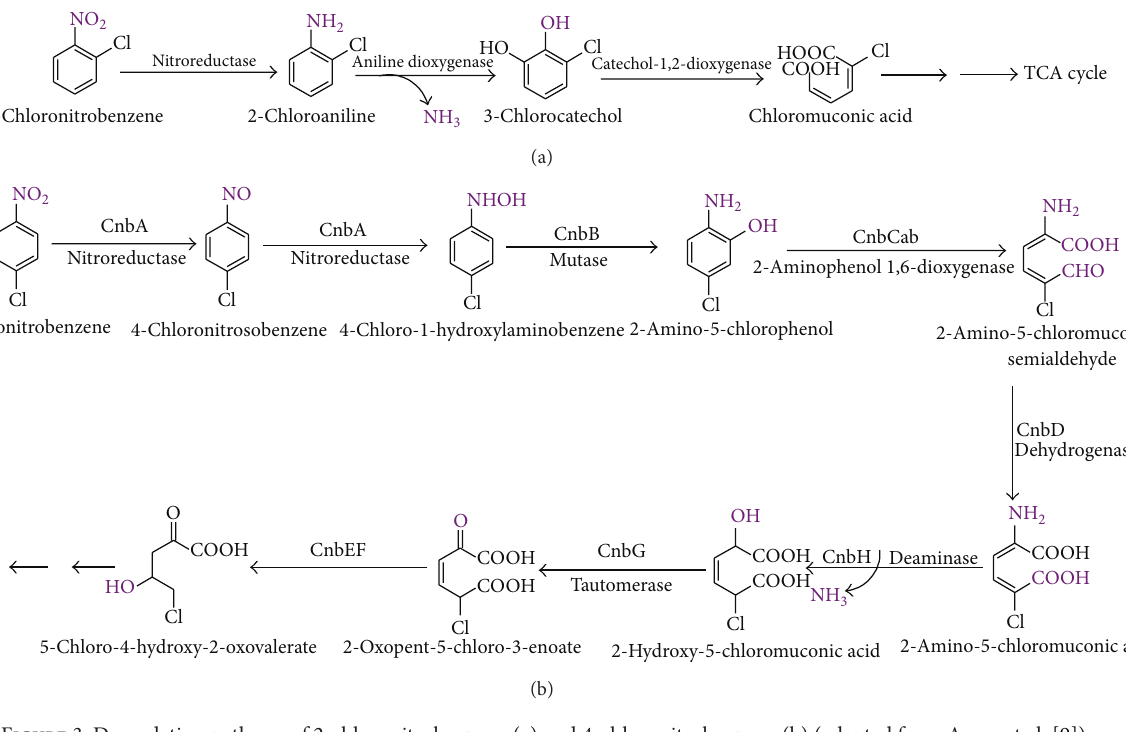
that the optimum salinity for nitrobenzene degradation was between 0.25% and 1%. The optimum mass concentrations of 3+ 2+ 2+ 3+ , Ni , Zn , Al , and Cr (VI) enhanced nitrobenzene Fe degradation; however, high concentrations of Fe 3+ , Ni 2+ , Zn 2+ , Al 3+ , and Cr (VI) inhibited the nitrobenzene degrada- tion